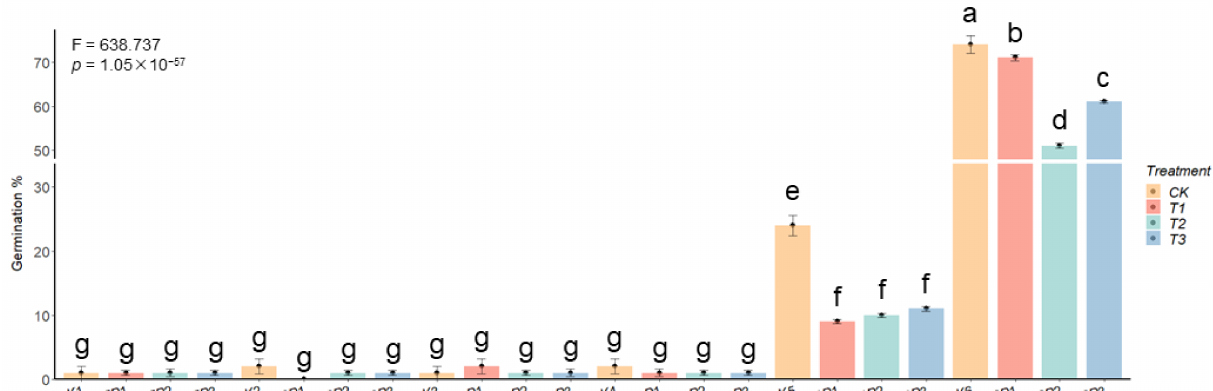
Figure 5. Germination of seeds initiated by osmoregulation treatment with different concentrations of PEG-6000. The osmoregulation of three concentrations of PEG-6000 solution at “day” 16 h/25 ◦ C and “night” 8 h/20 ◦ C, was used to initiate the germination test on seeds. The germination percentage of M. polymorpha seeds was not considerably increased by PEG-6000. More than two years of storage caused the seeds to lose their fundamental viability. PEG-6000 solutions at 50 g L − 1 , 100 g L − 1 , and 150 g L − 1 are referred to in the treatment columns T1, T2, and T3, respectively. The results of the analysis of the significance of differences between multiple samples, based on Duncan’s multiple range test, are represented by the lowercase letters a through g, with a denoting the most significant difference and g denoting the least significant difference, at a significance level of